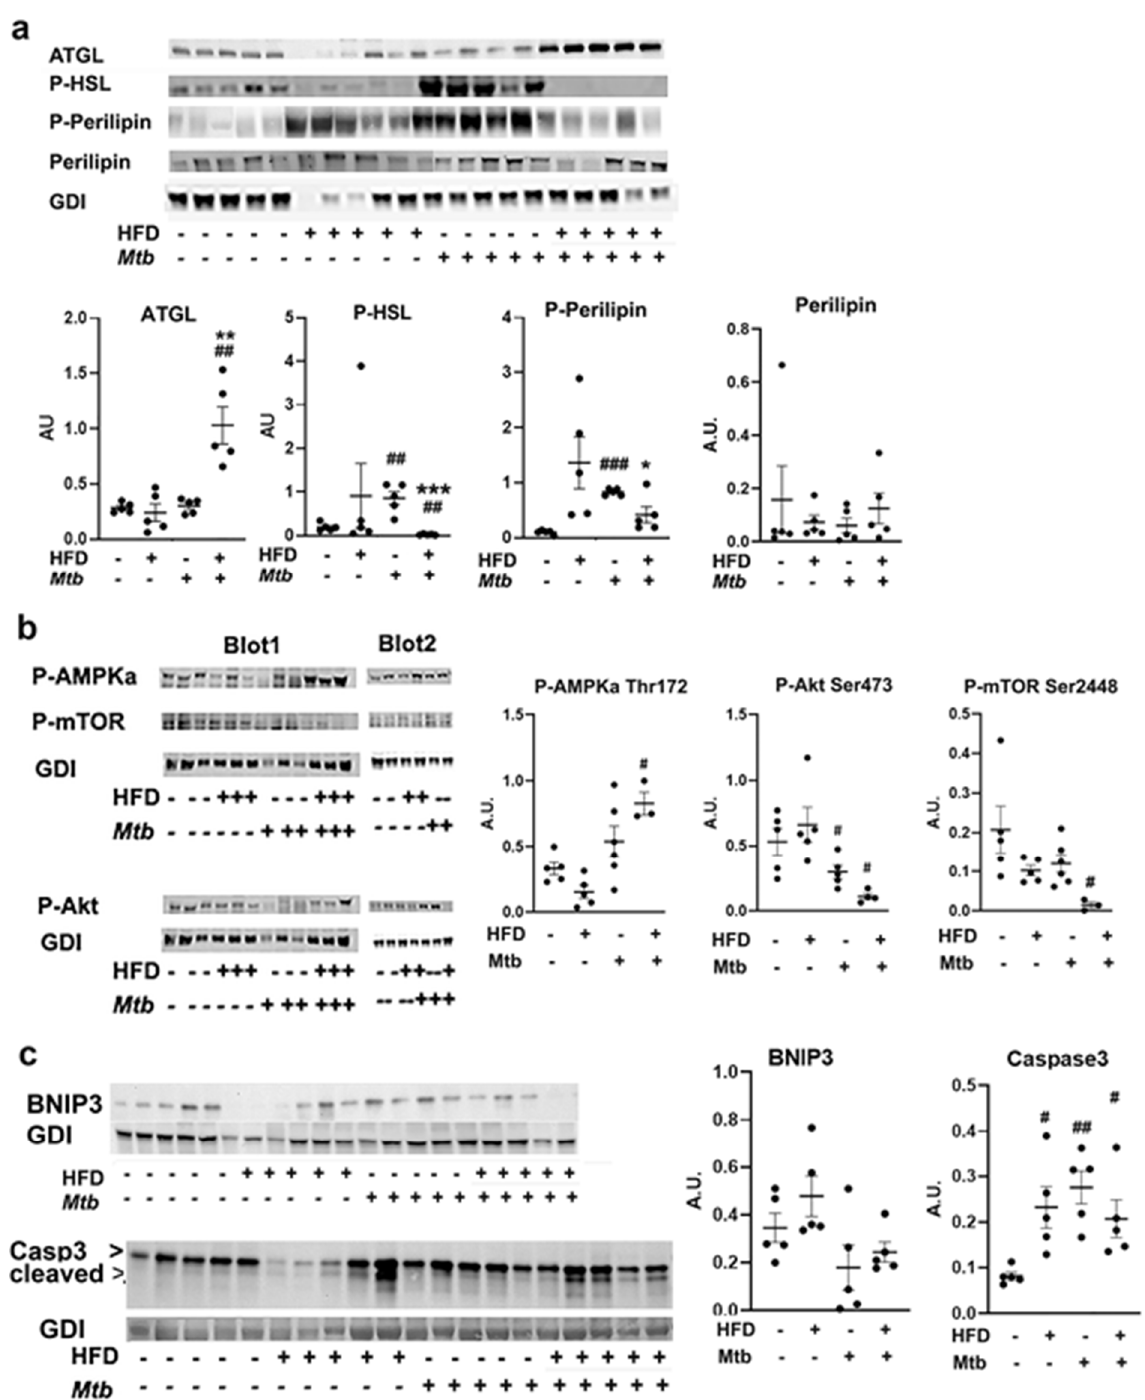
Figure 5. Mtb infection induces adipocyte lipolysis and apoptotic cell death in adult infected mice ( a ) Immunoblot analysis of lipid metabolism proteins (ATGL, P-HSL, P-Perilipin Ser 522, Perilipin) in the WAT lysates of infected and uninfected adult mice. ( b ) Immunoblot analysis of cell metabolic pathway proteins (P-AMPK α Thr 172, P-Akt Ser473, P-mTOR Ser 2448) in the WAT lysates of infected and uninfected adult mice. ( c ) Immunoblot analysis of cell death pathway proteins, necrosis (BNIP3) and apoptosis (Caspase3) in the WAT lysates of infected and uninfected adult mice. GDI was used as loading control. Fold changes in the protein levels were normalized to GDI expression and are represented as a dot plot. The error bars represent standard error of the mean. # p < 0.05, ## p < 0.01, and ### p < 0.001, compared to uninfected RD mice, * p < 0.05, ** p < 0.01 and *** p < 0.001 compared to infected RD mice from n = 5/group.